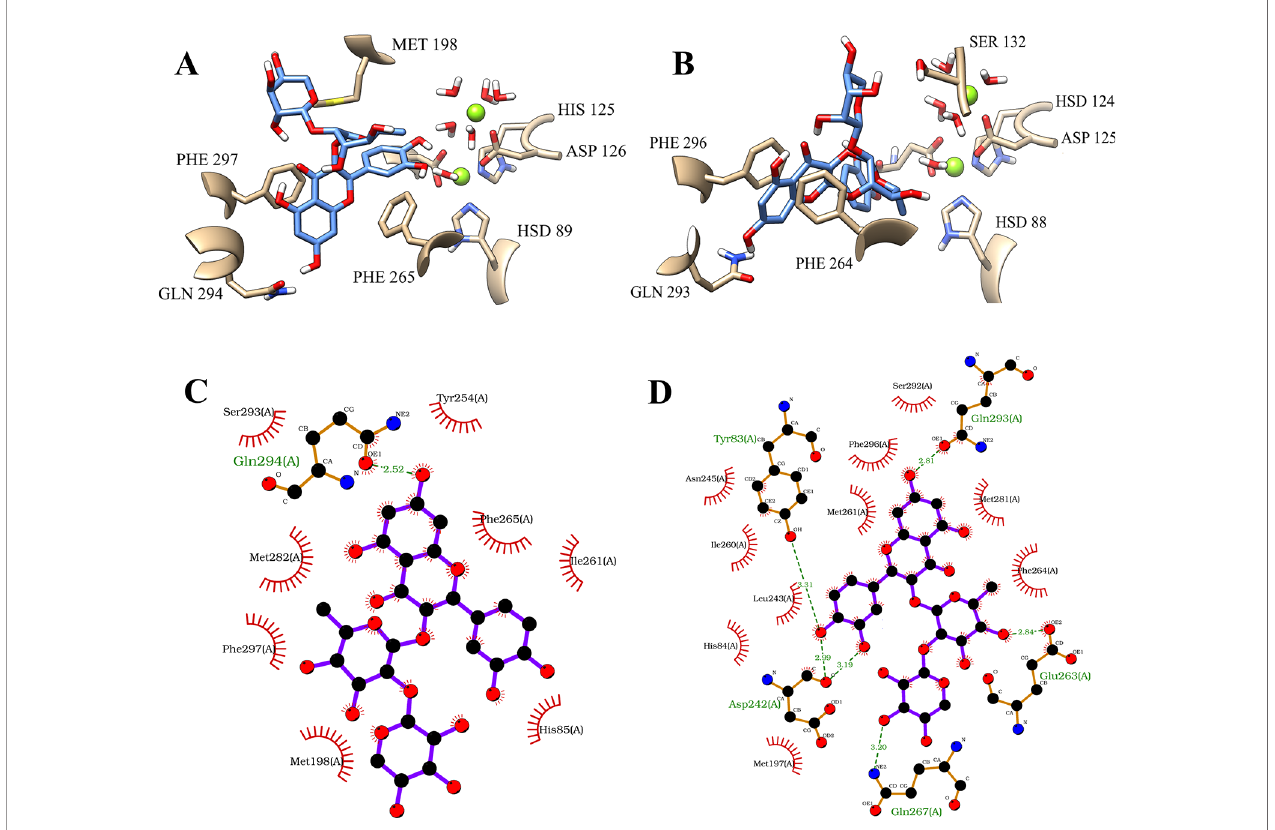
FIGURE 5 | Illustration of interactions between compound 1 (blue) and the amino acid residues of PDE4A (A) and PDE4B (B) for the fi fth pose. 2D representation of the intermolecular interactions between the compound 1 and PDE4A (C) and PDE4B (D) . The 2D diagrams was provided by the program